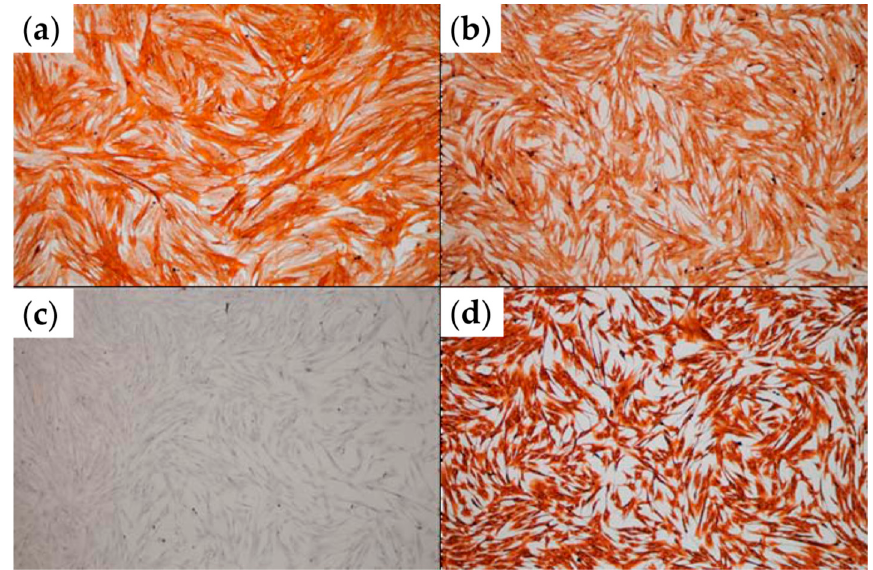
Figure 2. Immunocytochemical analysis of TAFs expanded in 2D culture. ( a ) α -SMA staining; ( b ) CD105 staining; ( c ) pan-CK staining; ( d ) vimentin staining (optical microscopy, ob. 10×).